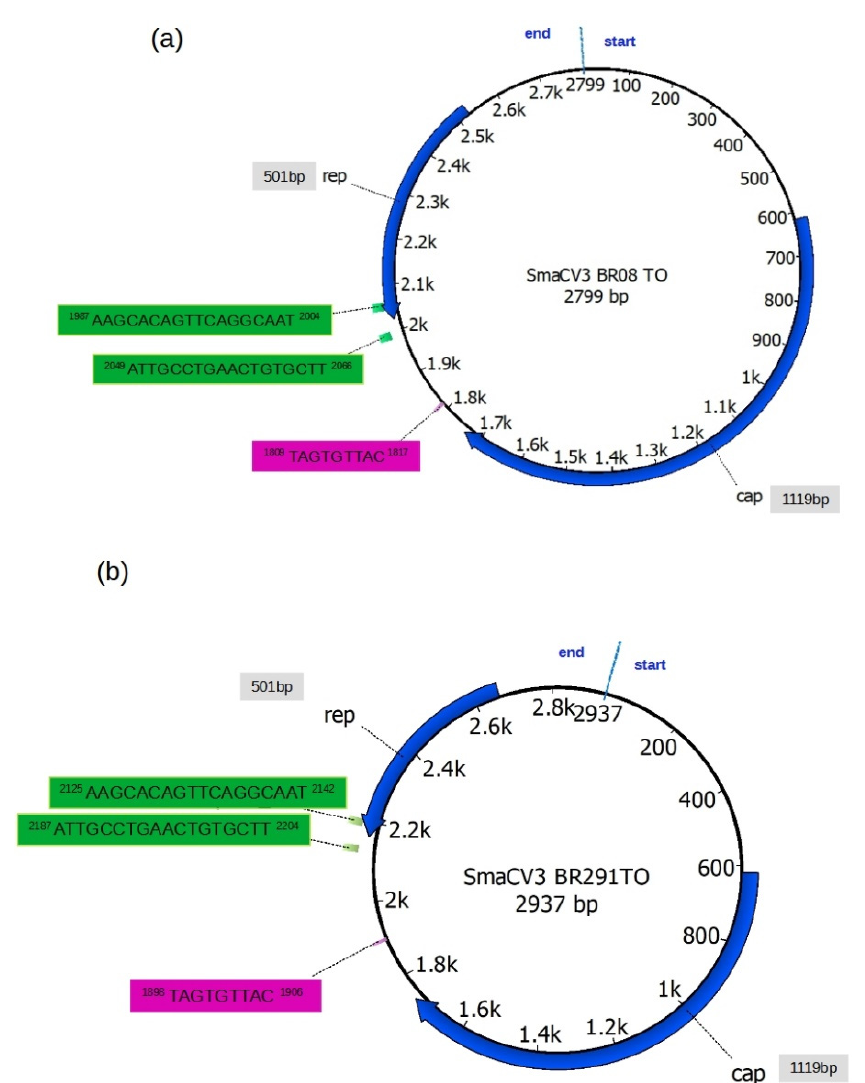
Figure 1. Genomic annotation of Brazilian porprismacoviruses. ( a ) Genomic map of the sequence SmaCV3BR08 and ( b ) map of the sequence SmaCV3BR291. Both sequences were annotated